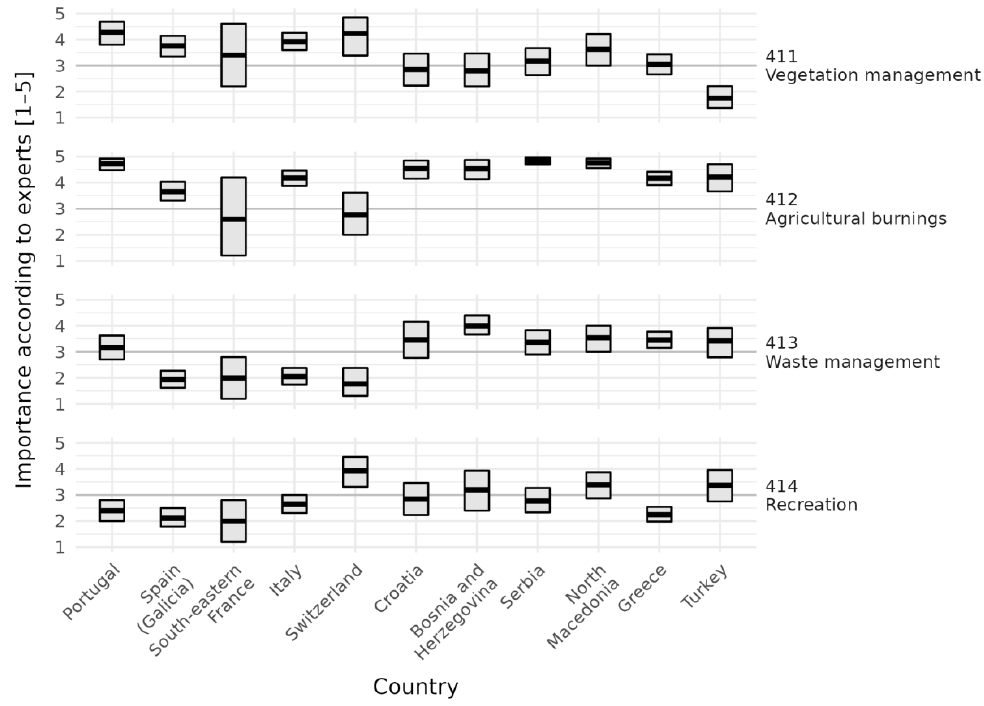
Figure 7. Crossbar plot of the importance of ignition due to Negligent use of fire , according to the smean.cl.boot function from the Hmisc R-package, grouped by